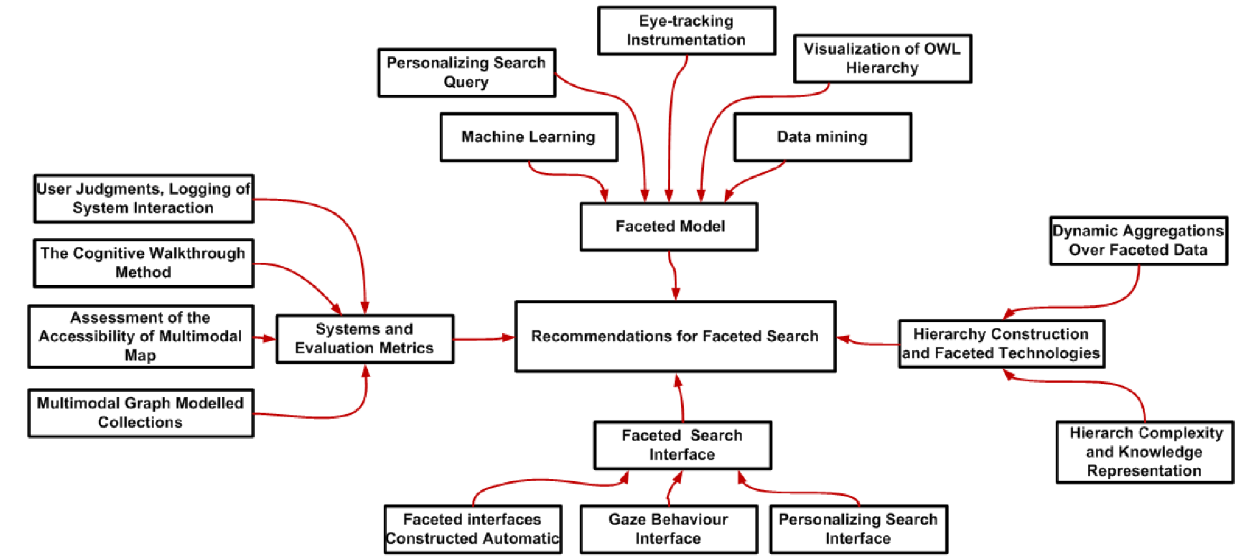
Figure 11. Categories of recommendations on faceted